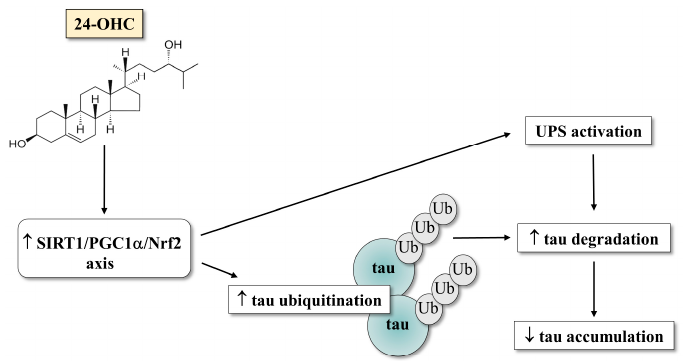
Figure 9. A hypothetical scheme for the proteasome degradation of tau by 24-OHC via SIRT1- dependent pathway.